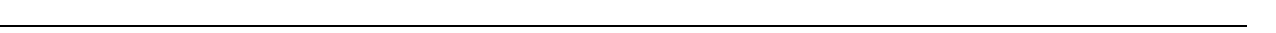
Fig. 8 Erk5 protects against metabolic stress-induced cardiomyopathy. a The expression of Erk5, Mef2a, and Mef2d were examined in the hearts from CKO mice injected with AAV9-GFP or AAV9-Erk5 followed by 16-week chow or HFD feeding. Actin is the protein loading control. b DHE staining indicated less ROS production in AAV9-Erk5-HFD hearts ( left panel , scale bar : 20 μ m). Fluorescence intensity was quanti fi ed ( right panel ). c TUNEL assay by triple staining with DAPI ( blue ), anti- α -actinin antibody ( red ), and TUNEL ( green ) determined fewer apoptosis in AAV9-Erk5 injected HFD-CKO hearts ( left panel , scale bar : 20 μ m), arrows indicated TUNEL positive nuclei. Quanti fi cation of TUNEL positive nuclei is represented by the bar graphs ( right panel ). d Masson ’ s trichrome staining detected less interstitial fi brosis in AAV9-Erk5 injected HFD-CKO hearts ( left image , scale bar : 50 μ m). Quanti fi cation of the fi brosis area is shown in the bar graphs ( right panel ). Restoration of Erk5 in CKO hearts improved e cardiac function and mitochondrial function evidenced by f increased the content of mtDNA, g enhanced complex I respiration rate, h elevated ATP production along with RCR, and i improved mitochondrial oxidation capability indicated by β -hydroxylacyl CoA dehydrogenase and pyruvate dehydrogenase (Pdh). n = 6 mice per group. Data are presented as means ±